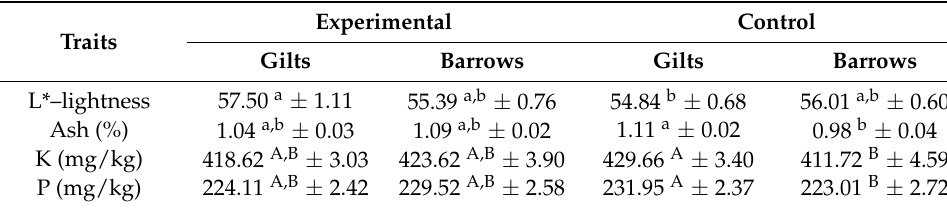
Table 8. Interactions (group ×